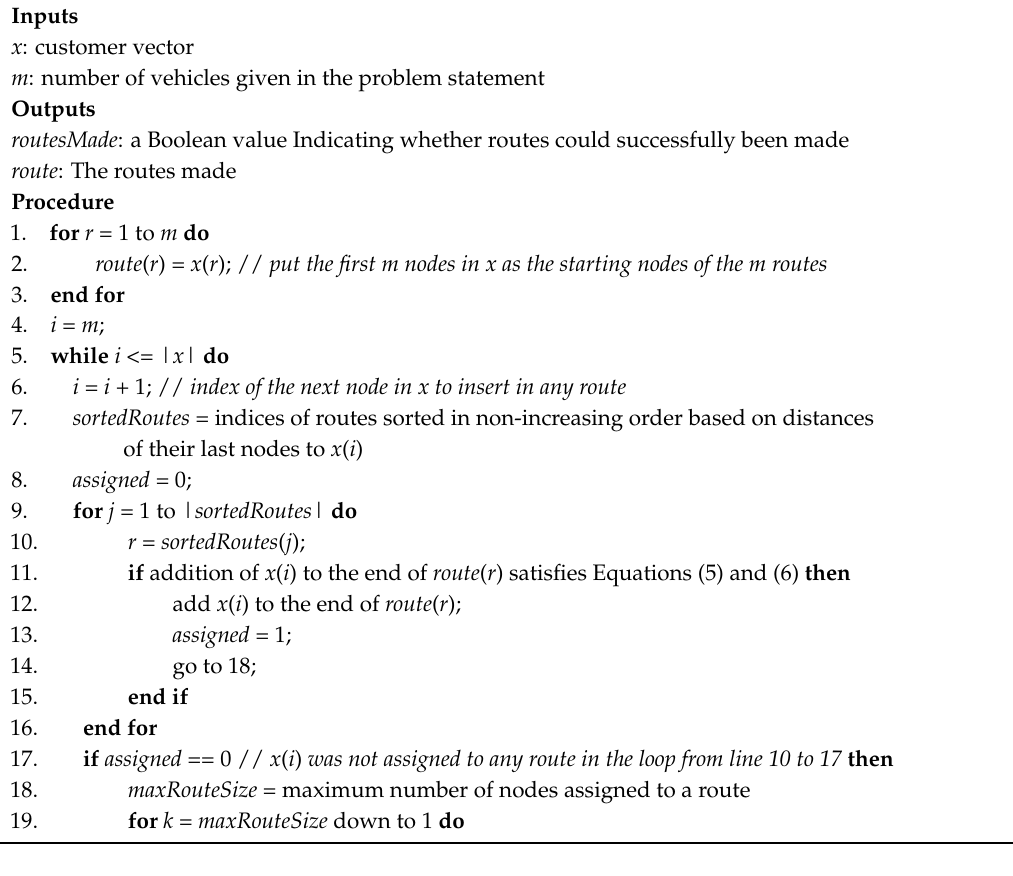
Algorithm 1. Distance-based decoding method.